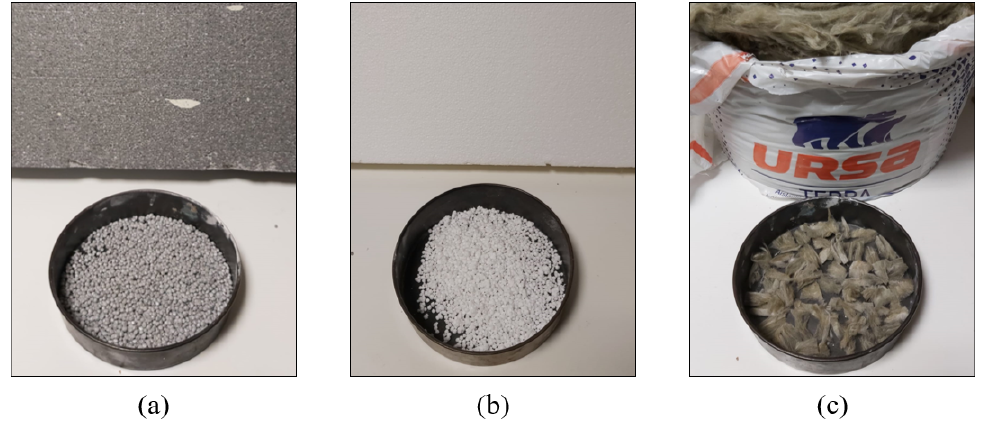
Figure 2. Waste insulation used. ( a ) Expanded polystyrene with graphite for use in facades; ( b ) ex- panded polystyrene for indoor use; ( c ) mineral wool.